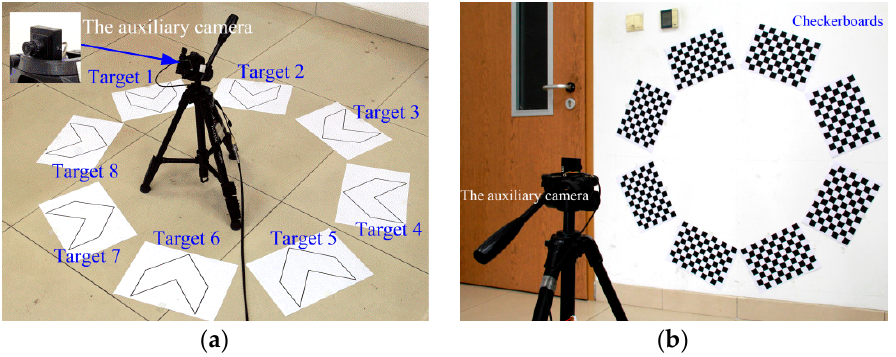
Figure 11. Global calibration of eight targets: ( a ) Eight targets and the auxiliary camera in the real experiment; ( b ) The auxiliary camera captures eight checkerboards in one image frame.